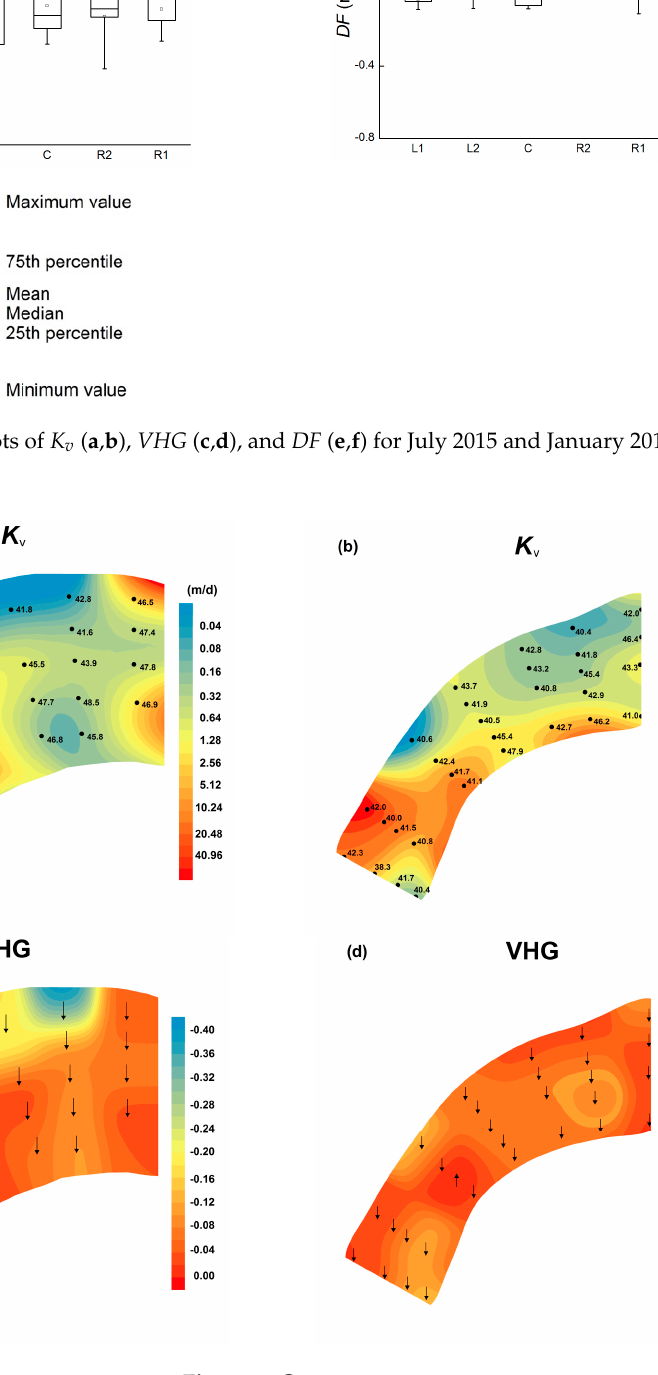
Figure 3. Box plots of K v ( a , b ), VHG ( c , d ), and DF ( e , f ) for July 2015 and January 2016.